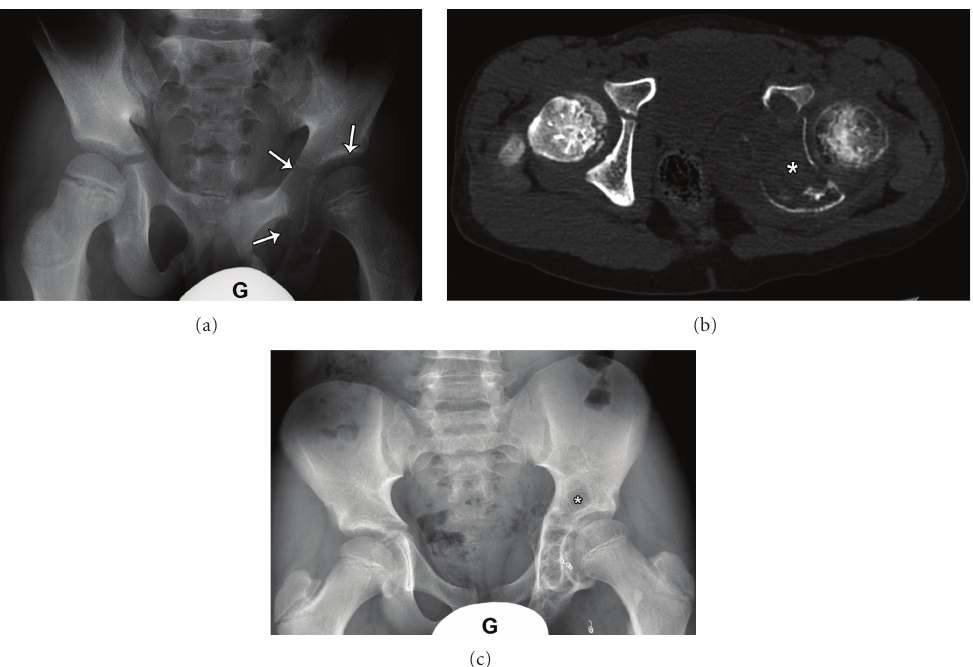
Figure 6: 8-year-old male presented with left hip pain, diagnosed as Aneurysmal bone cyst. Plain film (a) demonstrates large expansile lytic lesion (arrows) involving medial left acetabulum extending to the inferior pubic rami (G: gonadal shield). Axial CT scan (b) obtained immediately following curettage and packing with bone allograft showing relatively dense material (asterisk) within the expanded left Ischium. Follow-up plain film (c) five years postsurgical curettage and embolization (note the embolization coils along the medial aspect of the hip) shows healing of the ABS with return to normal contour and course trabeculation. Unfortunately, a focus of recurrence is also noted in the superior acetabulum (asterisk). Local recurrence is not common, but